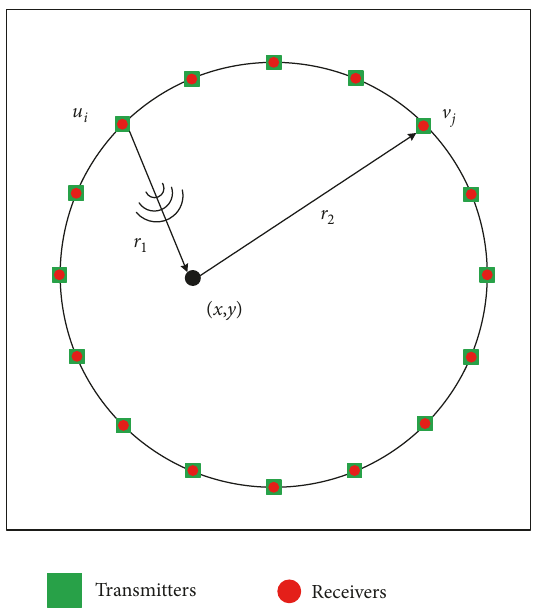
Figure 1: Schematic diagram of data acquisition for the total focusing